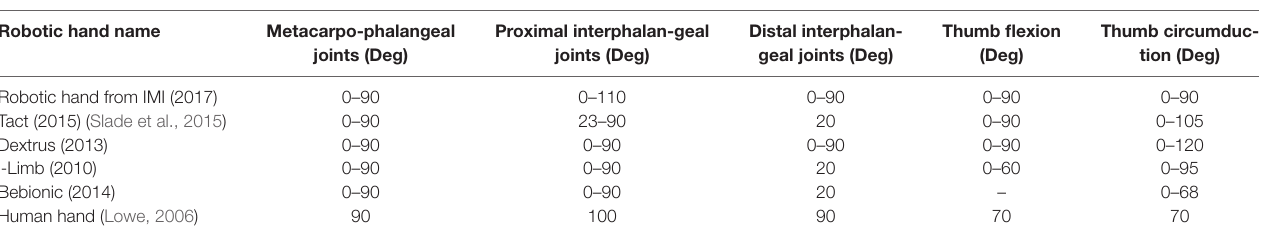
TaBle 1 | Hand joint moving angle.